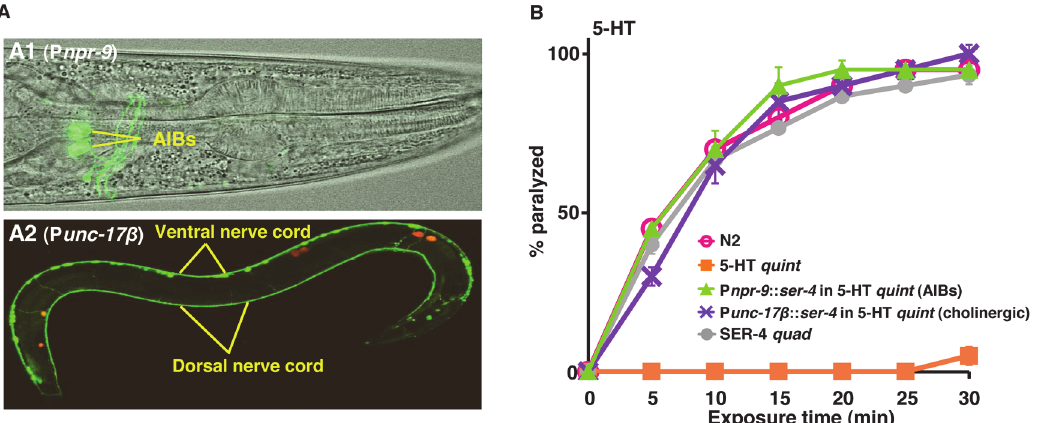
Fig 2. The 5-HT/SER-4-dependent inhibition of either the AIB interneurons or cholinergic motor neurons causes locomotory paralysis. A. Confocal images of 5-HT quint expressing SER-4::GFP in the AIB interneurons (P npr-9 )(A1) or cholinergic motor neurons (P unc-17 β )(A2). GFP fluorescence (A2) or GFP fluorescence overlaid on DIC image (A1). The red stain in A2 is coelomocyte-specific RFP screening marker. B. Paralysis of wild type, mutant and transgenic C . elegans on hypotonic, non-NGM agar plates. Wild type, quadruple 5-HT receptor null animals expressing only SER-4 (SER-4 quad ) or 5-HT quint expressing the C . elegans 5-HT 1 -like receptor, SER-4, in either the cholinergic motor neurons (P unc-17 β ) or the two AIB interneurons (P npr-9 ) were examined for 5-HT (1 mM)-dependent paralysis as outlined in Methods. Data are presented as mean ± SE (n = 3).